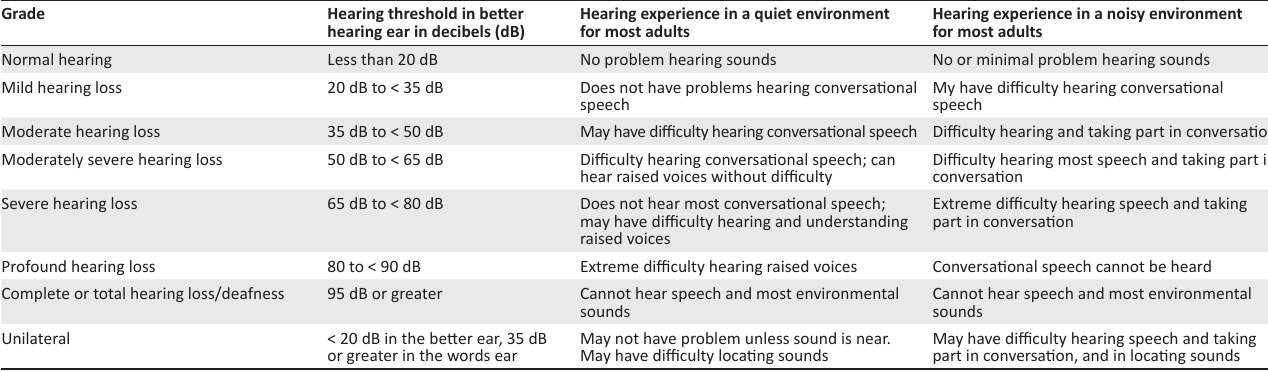
TABLE 1: World Health Organization framework for hearing loss.